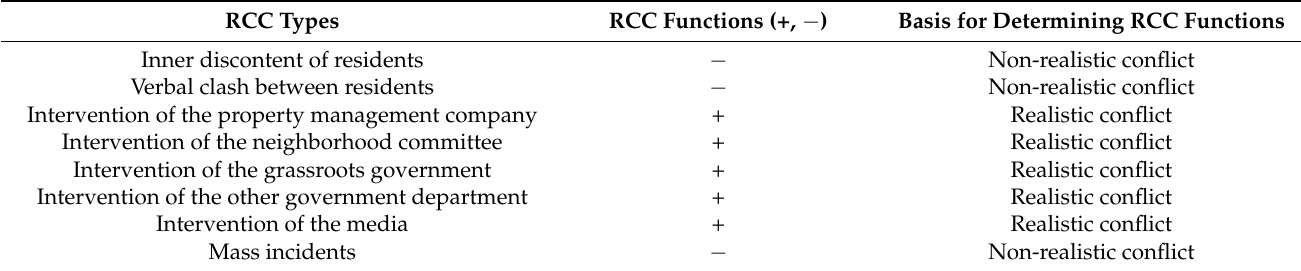
Table 2. Conflict functions based on different types of